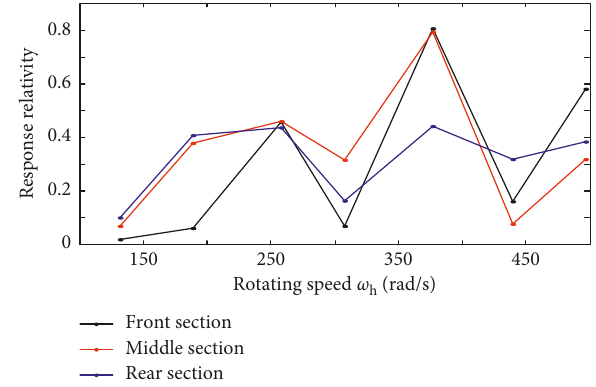
125rad/s, ω l 105rad/s, (c) ω h (cid:30) (cid:30)